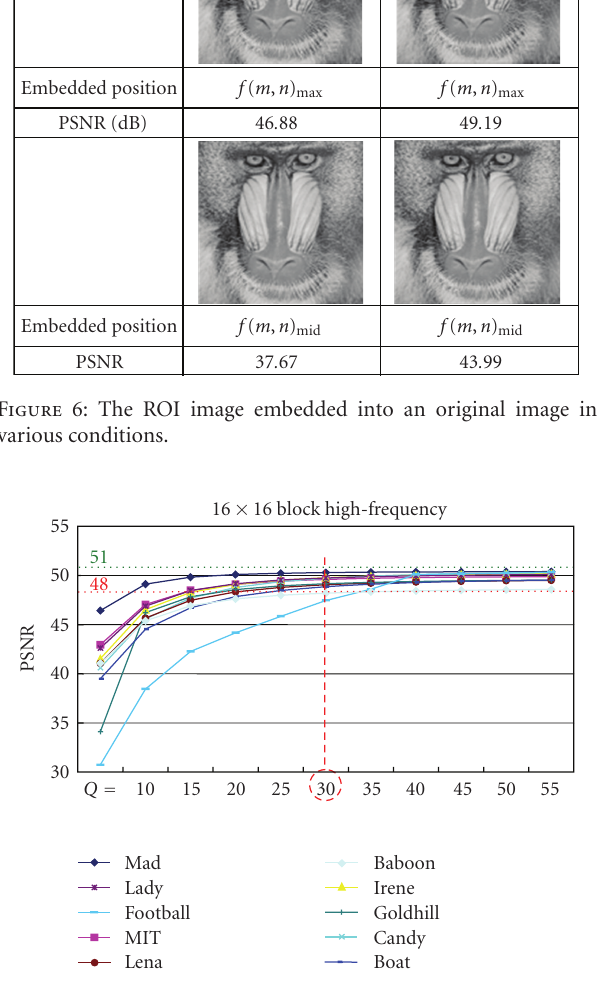
Figure 7: The quality of composite image as ROI embedded in various quantization.